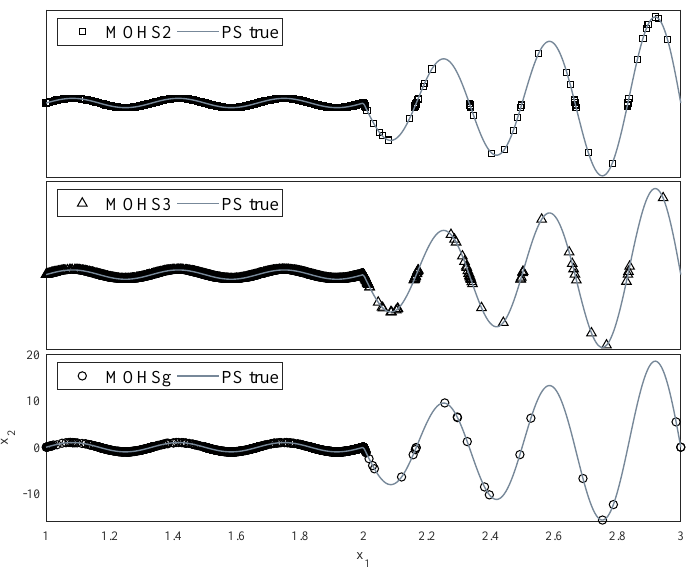
Figure 3. Pareto sets for problem